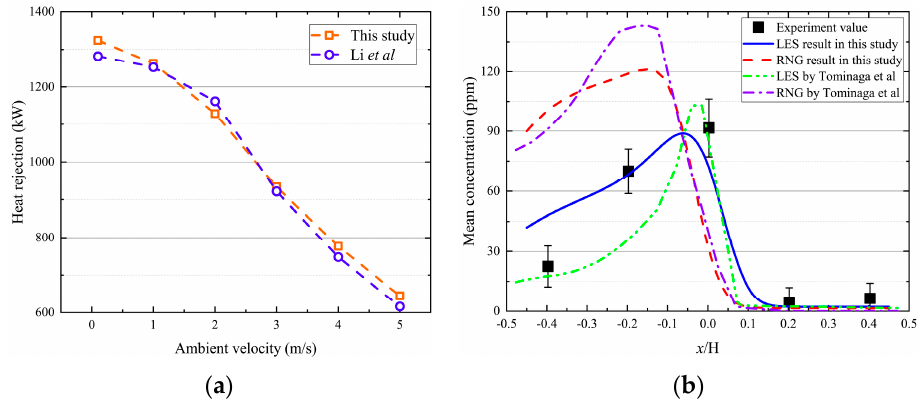
Figure 5. Numerical model validations: ( a ) heat transfer validation with Li et al. [27] and ( b ) pollutant dispersion validation with experiment results [20].